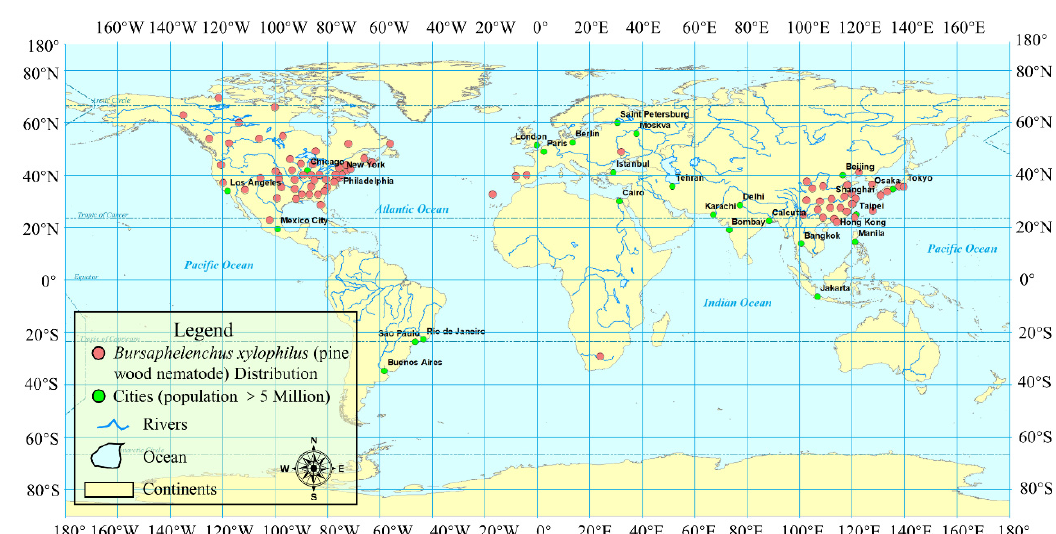
Figure 1. The global distribution of pine wilt disease (data source: https://www.cabi.org/ISC; accessed on 16 August 2021).